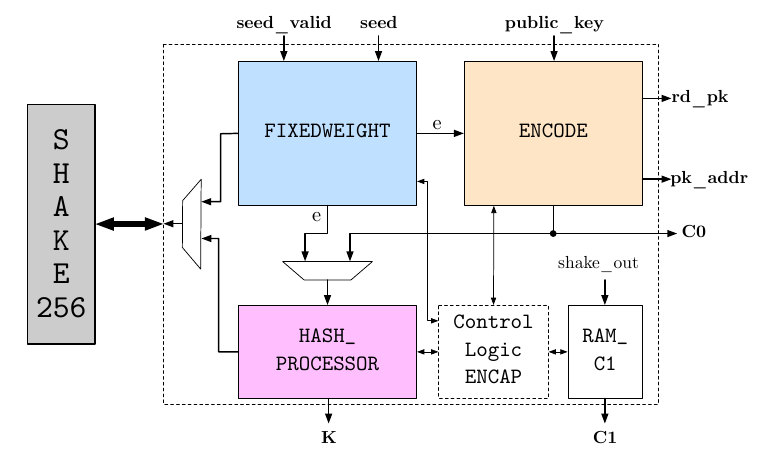
Figure 19: Hardware design of Encap module interfaced with SHAKE256